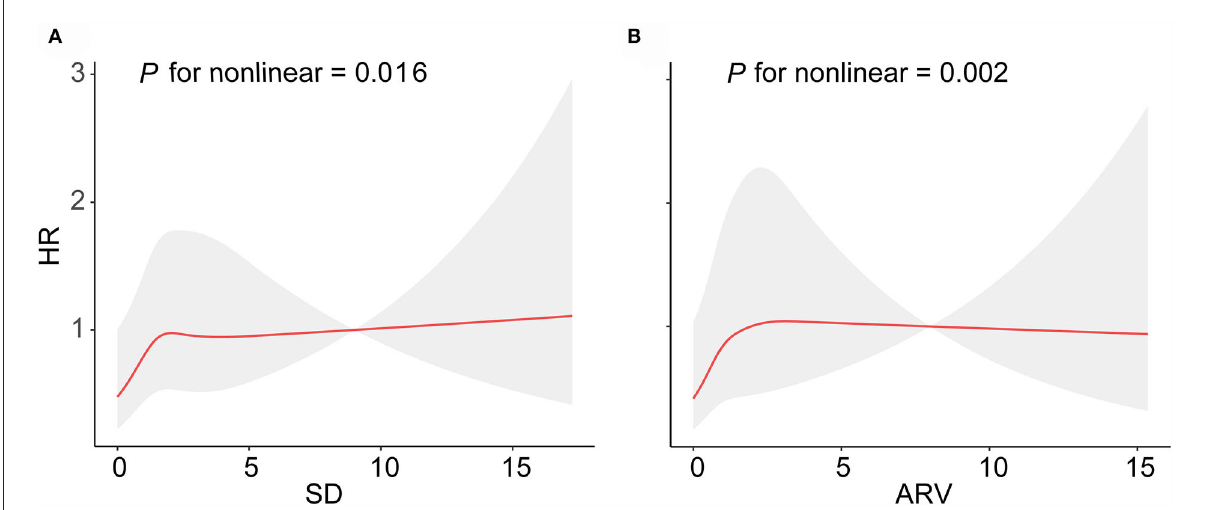
FIGURE2 Curve association between SD and ARV for BMI variability and the risk of lung cancer. Shading indicates 95% CIs. (A) SD for BMI, (B) CV for